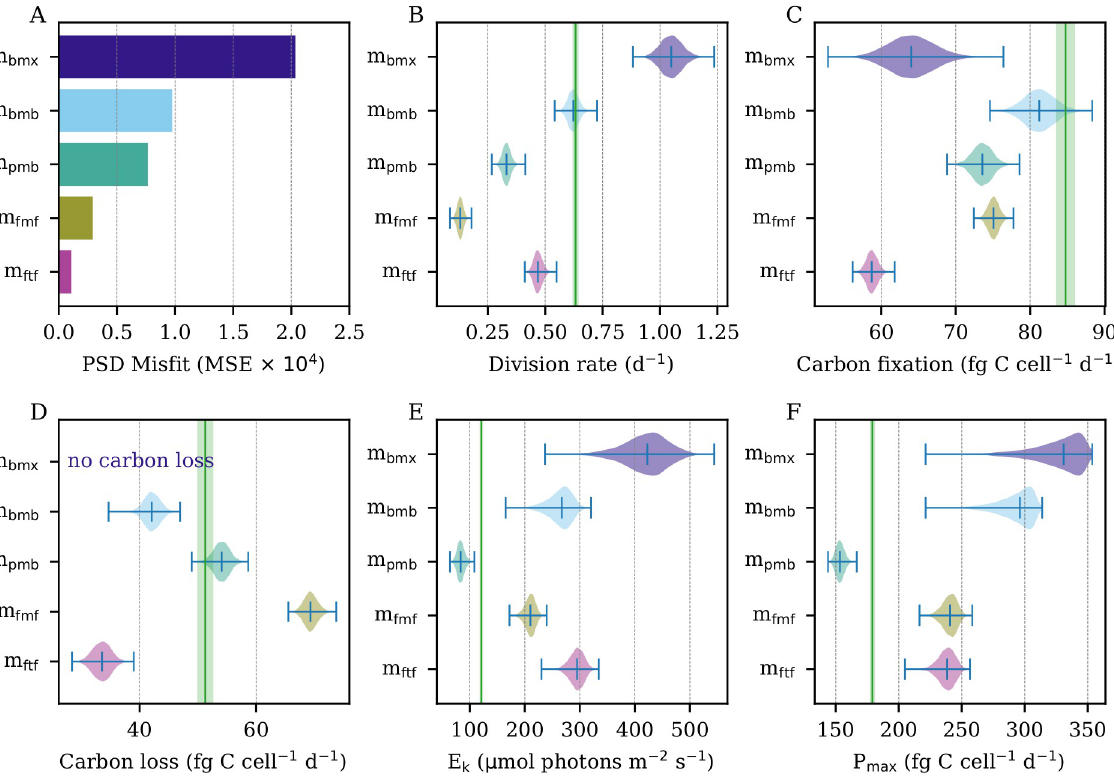
Fig 4. Model estimated daily rate parameters. (A) Mean squared error (MSE) of estimated proportions to the observed particle size distribution (PSD). (B) Estimated daily division rates. (C) Estimated daily carbon fixation. (D) Estimated daily carbon loss. (E) Estimated photosynthetic saturation parameter. (F) Estimated maximum photosynthetic rate. (B-F) Green vertical lines indicate ground truth calculated from data. Green shaded areas indicate uncertainty surrounding ground truth measurements. Model estimates shown as posterior